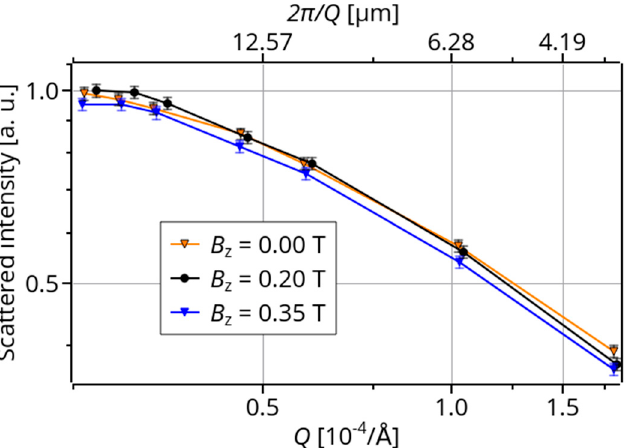
Figure 4. USANS curves of the MAE sample with 67 mass% of Fe and a stiff matrix for different magnetic fields.